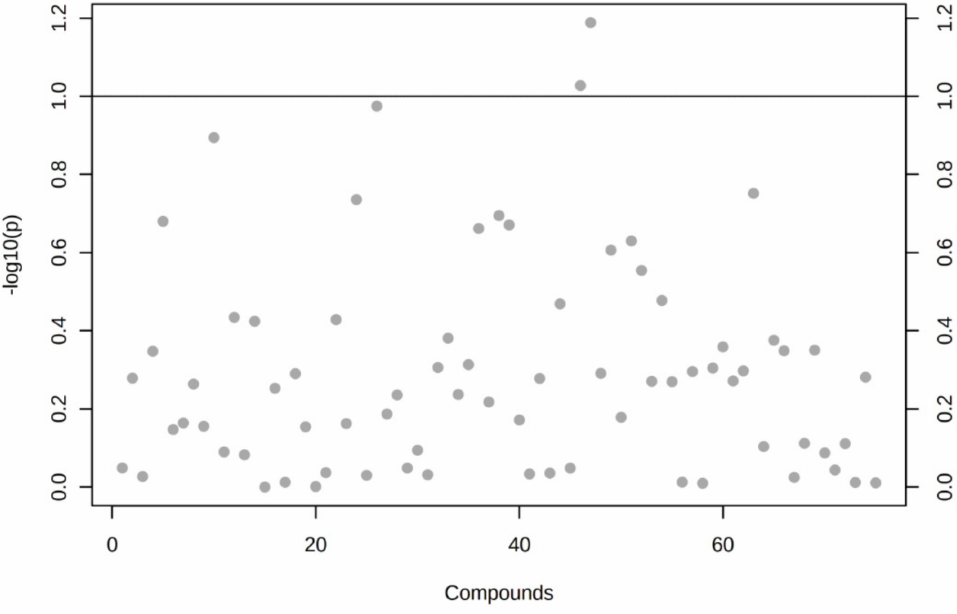
Figure A6. Graphical presentation of t-test analysis (FDR < 0.1) performed between T2DM and IFG fe-